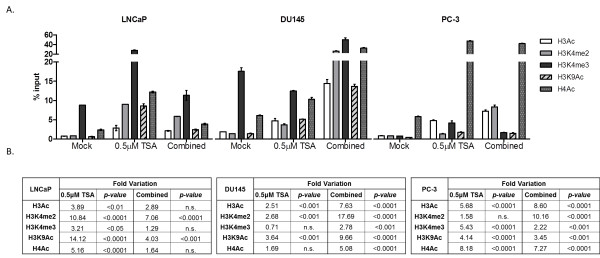
ChIP analysis of transcriptionally activating histone marks (H3Ac; H3K4me2; H3K4me3; H3K9Ac; H4Ac) binding to MDR1 promoter in LNCaP and DU145 cell lines both in untreated (Mock), TSA and TSA combined with DAC treated cells. (A) ChIP-qPCR data, normalized to the percent input method. (B) Fold variation of each histone activating mark, comparing treated cells with Mock cells.